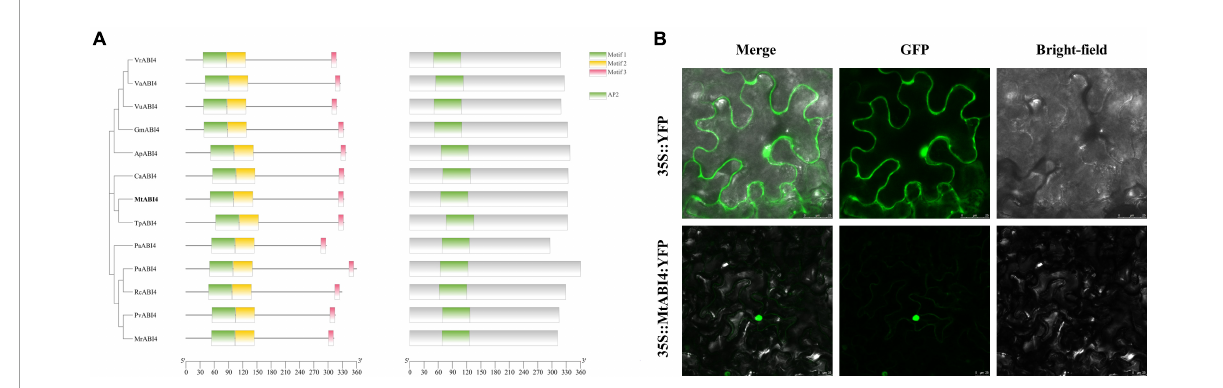
FIGURE1 Phylogenetic tree, motif analysis, protein structural domains, and the subcellular localization of ABI4. In (A) different color blocks represent different motifs and structural domains. The scale bar represents the length of the amino acid sequence. (B) Represents the subcellular localization of ABI4.